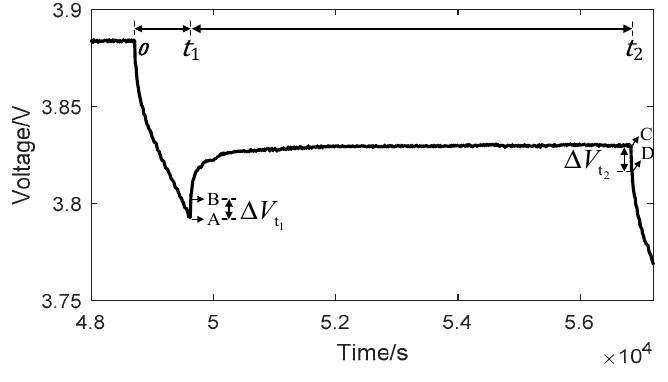
Figure 5. Transient voltage response.